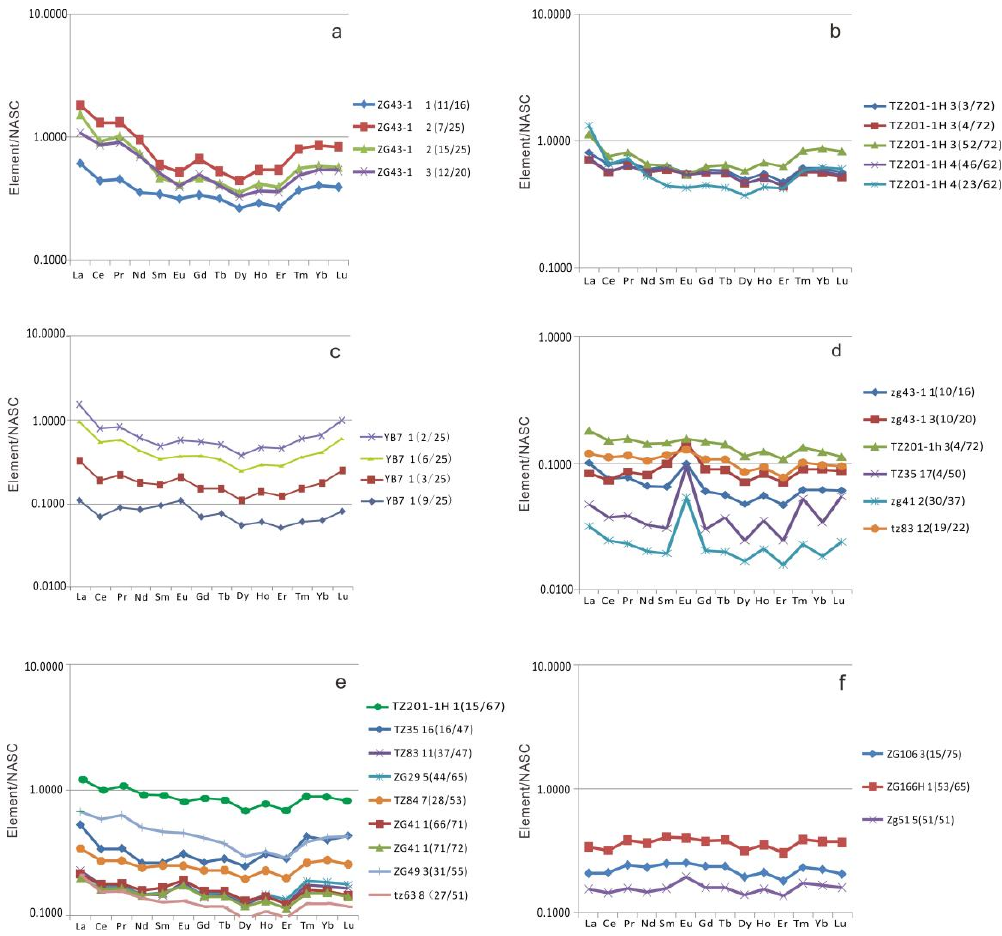
Figure 10. Rare earth distribution patterns of fillings in different layers or fracture ‐ caves. ( a ) REE distribution pattern of the fracture ‐ cave fillings in the LG43 ‐ 1 Yingshan Formation is rightward, with negative Eu anomalies ( δ Eu average 0.82); ( b ) REE distribution pattern of fracture ‐ cavity fillings in TL201 ‐ 1h Yingshan Formation, slightly right ‐ tilt, slightly negative Eu anomaly ( δ Eu average 0.91); ( c ) REE distribution pattern of the fracture ‐ cave fillings in the YB7 Yingshan Formation is ‘V’ type, with slightly positive Eu anomalies ( δ Eu average 1.05) (according to Wu et al. [27]); ( d ) REE distribution pattern of Yingshan Formation limestone, slightly right tilt, Eu positive anomaly ( δ Eu average 1.32); ( e ) REE distribution pattern I of limestone at the bottom of Lianglitage Formation, micro ‐ right ‐ dip type, and positive Eu anomaly ( δ Eu average 1.11); ( f ) REE distribution pattern II of limestone at the bottom of Lianglitage Formation, flat, and no Eu anomaly.